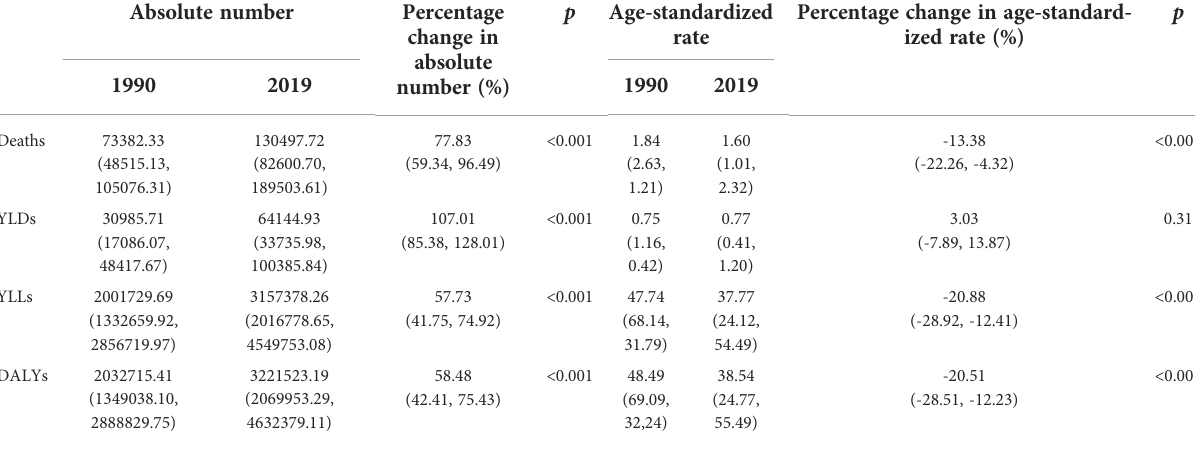
TABLE 1 Global cancer burden attributable to secondhand smoke for both sexes combined in 1990 and